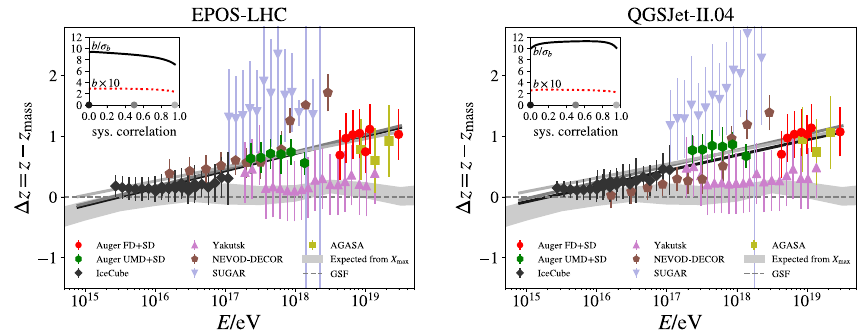
z mass distributions, as log ( E / 10 16 eV) to the ∆ z = z 10 · −